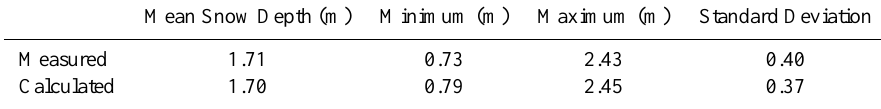
Table 3. Measured versus modeled mean, minimum, and maximum snow depth and standard deviation.